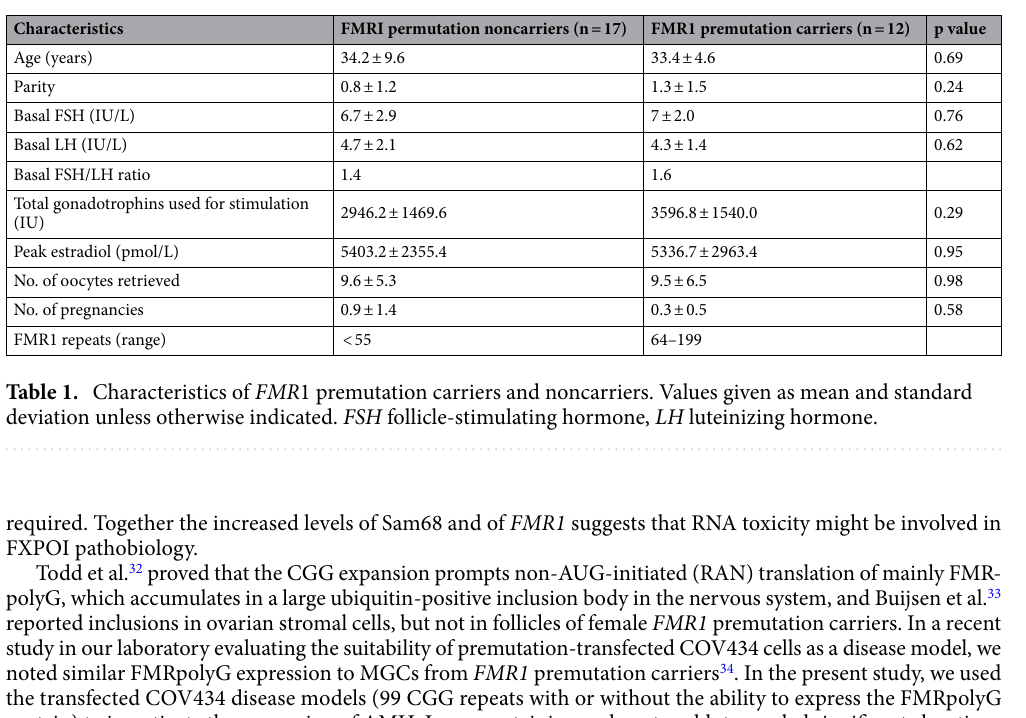
Figure 5. COV434 premutation model expressing higher AMH once in the premutation range. ( a ) 99xCGG- transfected COV434 cells displaying higher AMH expression than 20xCGG- transfected COV434 cells. GFP signal represents transfected cells. Bar = 10 µm. ( b ) Quantification of AMH expression in transfected COV434 cells shown in panel ( a ). ( c ) Western blot showing higher expression in COV434 transfected with 99xCGG with and without FMRpolyG expression. Values were normalized with untreated COV434. All groups were harvested 72 h following transfection.